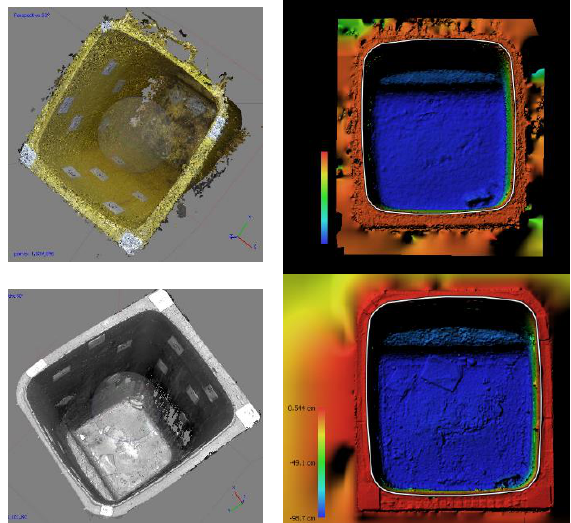
Figure 6: Dense point clouds (left) with associated DEMs (right) of the empty waste bin, Top: by photogrammetry, Bottom: by laser scanner The results of the experiments showed that the system works.